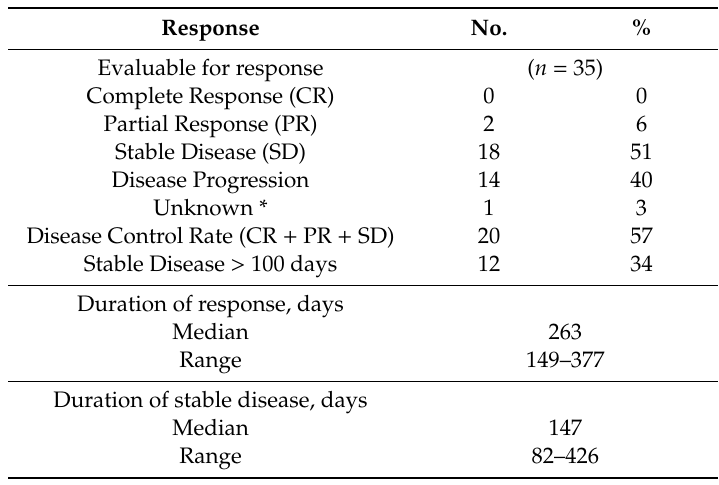
Figure 1. Best overall response of target lesions to glembatumumab vedotin. For each evaluable patient, the best response (defined by shrinkage in RECIST target lesions) is indicated ( n = 32). Dark blue bars indicate the patients with partial response, light blue columns show the patients who had stable disease, and red columns represent patients with the progression of disease. Asterisks indicate the patients who had appearance of new lesions at the first tumor evaluation. Of the 3 patients not shown, one patient died during cycle 1 due to the clinical progression of disease without post-baseline tumor assessment, and another was removed for grade 4 neutropenia and acute kidney injury during cycle 1 and did not have post-baseline tumor assessment. The third patient had a complete disappearance of target lesion(s) at the first post-baseline tumor assessment but was noted to have new tumors elsewhere, so the best response was classified as the progression of disease. This patient did not have tumor measurements entered into the database and was therefore not included in the graphical output. Table 2. E ffi cacy